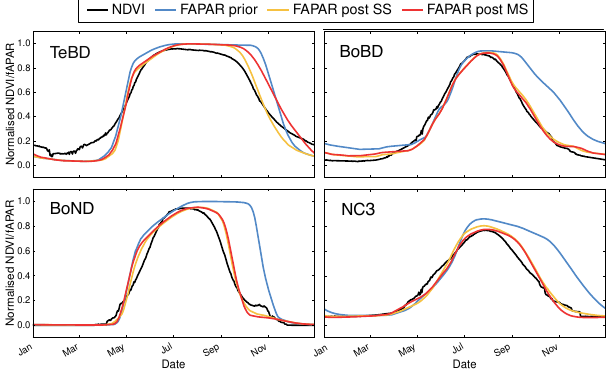
Figure 4. The mean seasonal cycle of the normalised modelled fA- PAR before and after optimisation, compared to that of the MODIS NDVI data, for the temperate and boreal deciduous PFTs (TeBD, BoBD, BoND and NC3). Black = MODIS NDVI data; blue = prior model; orange = single-site optimisation; red = multi-site optimisa-